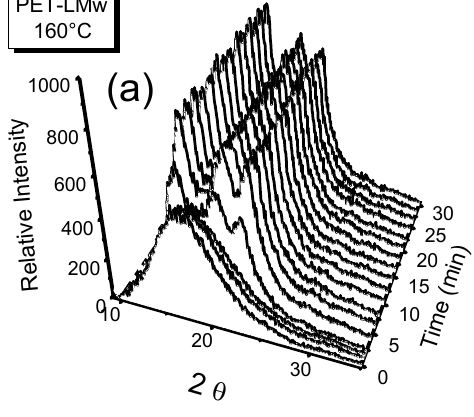
Figure 8. ( a ) Time-resolved WAXD patterns registered during the isothermal crystallization (30 min, 160 °C) of PET-LMw; Crystalline degree of isothermally crystallized PET at different temperatures: ( b ) PET-LMw; and ( c ) PET-HMw. Data were obtained from time resolved WAXD